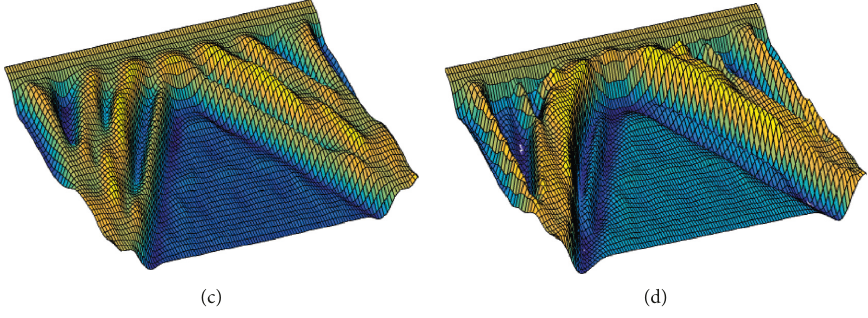
Figure 5: Level set surfaces at different